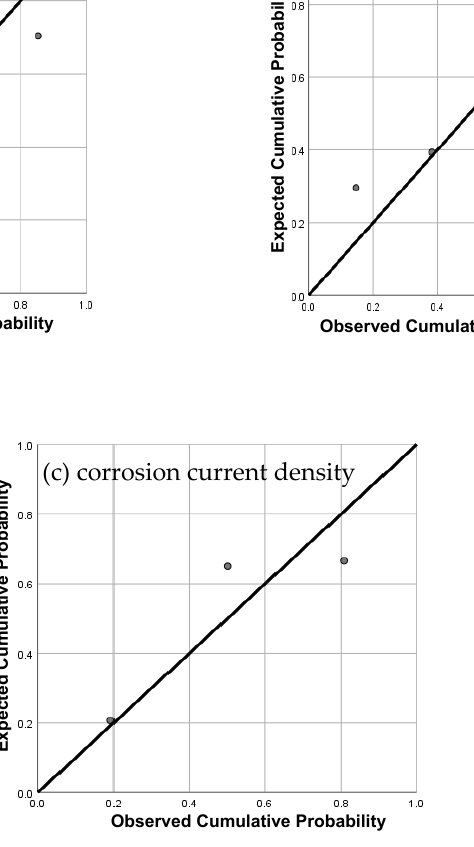
Figure 1. Normal probability plot of properties of austenitic stainless steel: ( a ) hardness; ( b ) tensile strength; ( c ) corrosion current density.